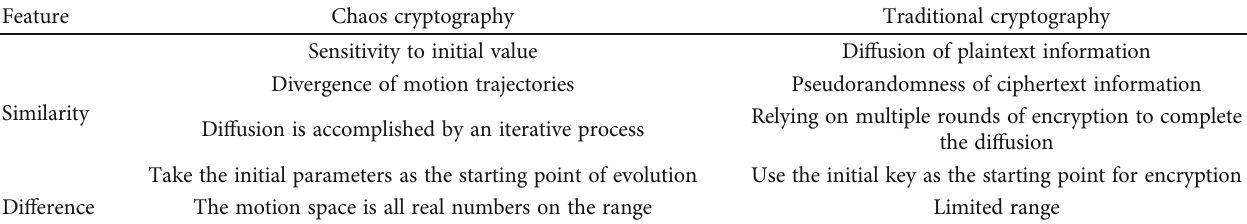
Table 1: Comparison of traditional cryptography and chaotic